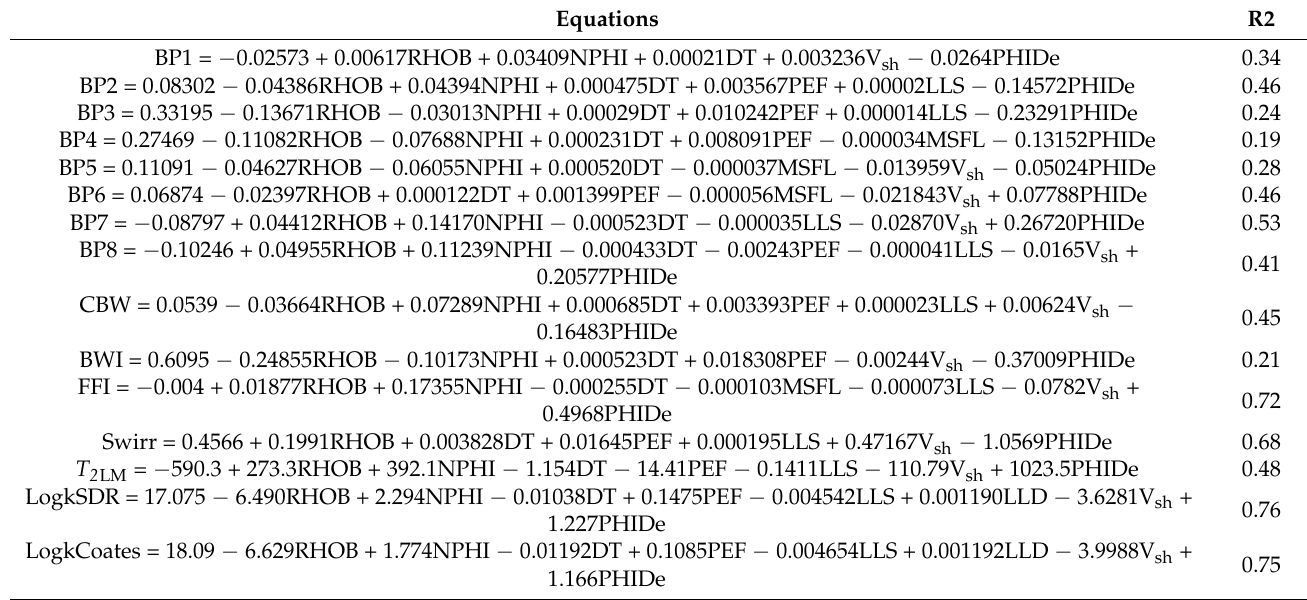
Table 4. Optimised MRA equations for the calculation of NMR log